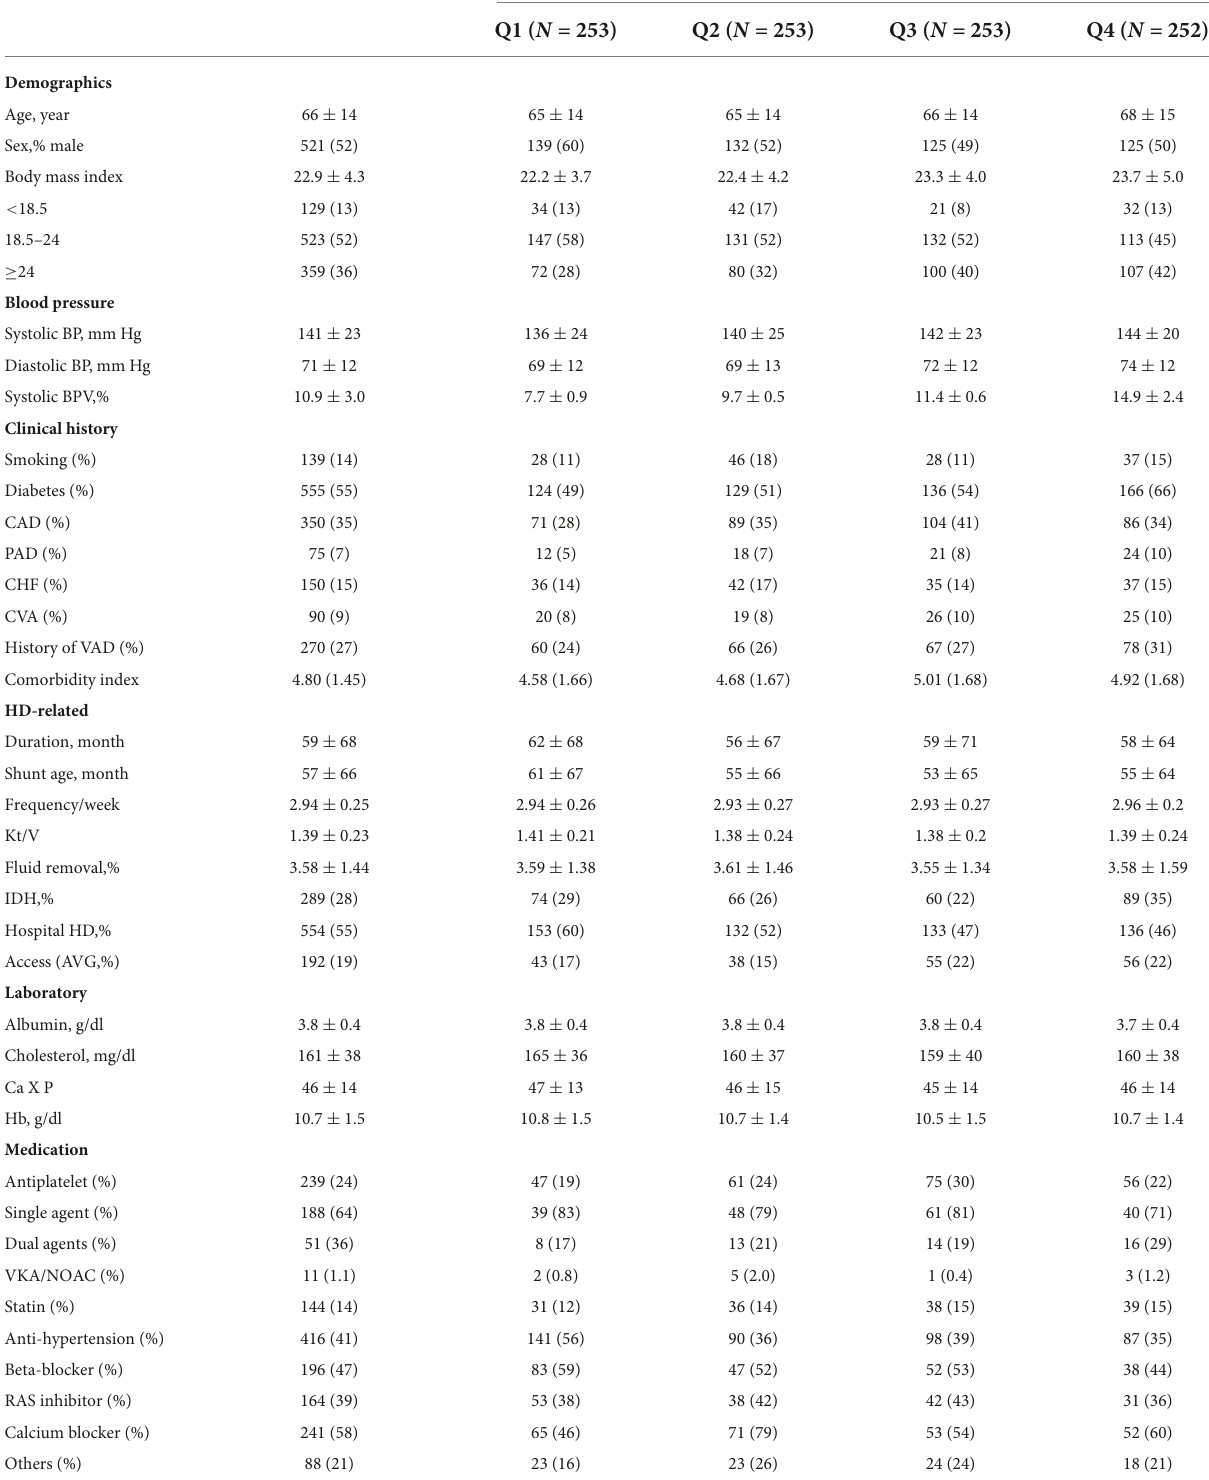
TABLE 1 Baseline characteristics stratified by systolic BPV